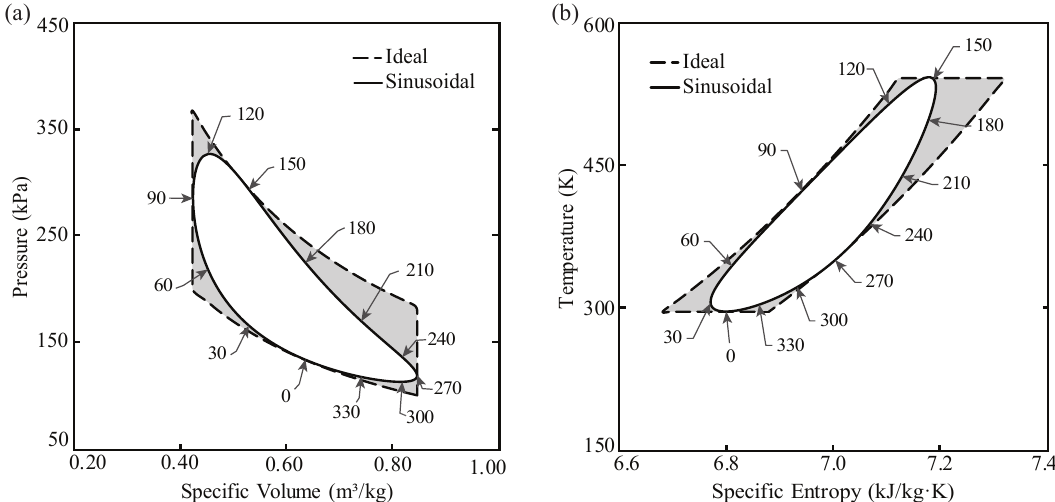
Figure 8. Sinusoidal and ideal cycle plots in ( a ) P - v and ( b ) T - s diagrams for the modeled beta and gamma-type Stirling